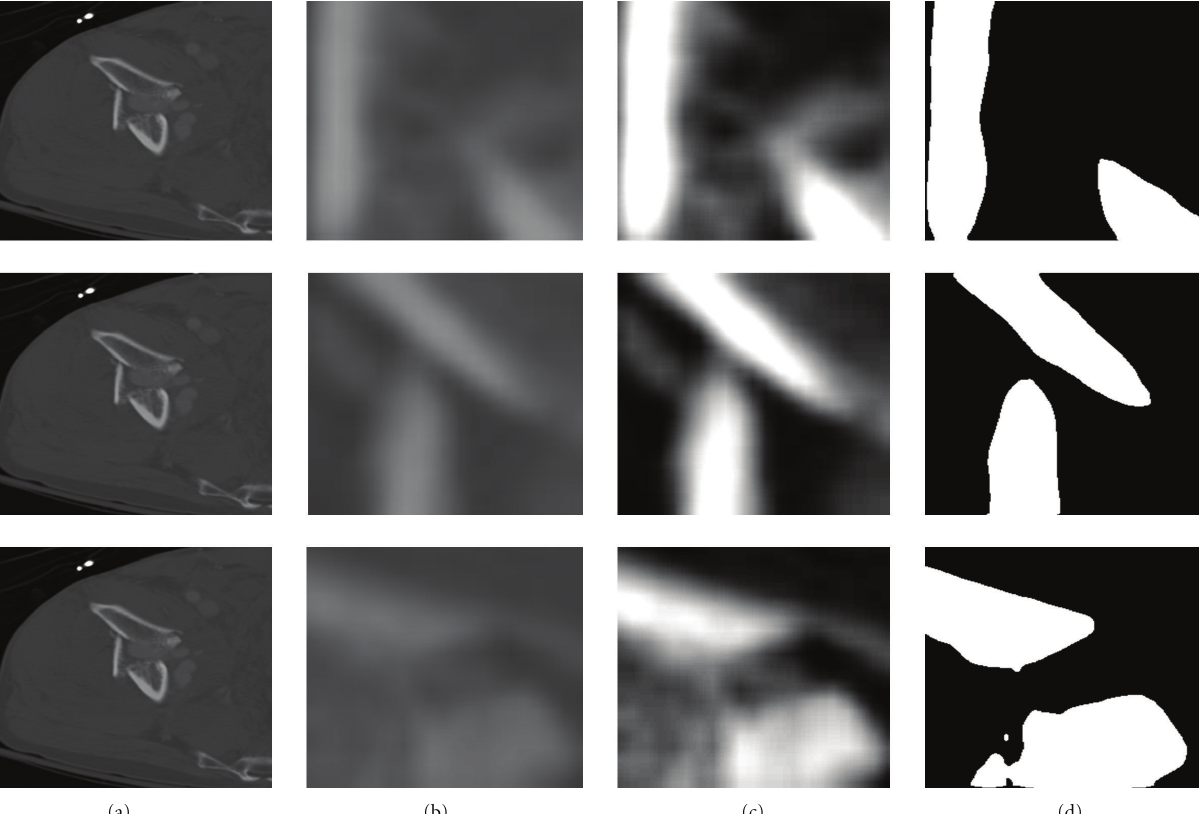
Figure 10: Example of a detected broken boundary of pelvic bone, which may indicate three fractures.